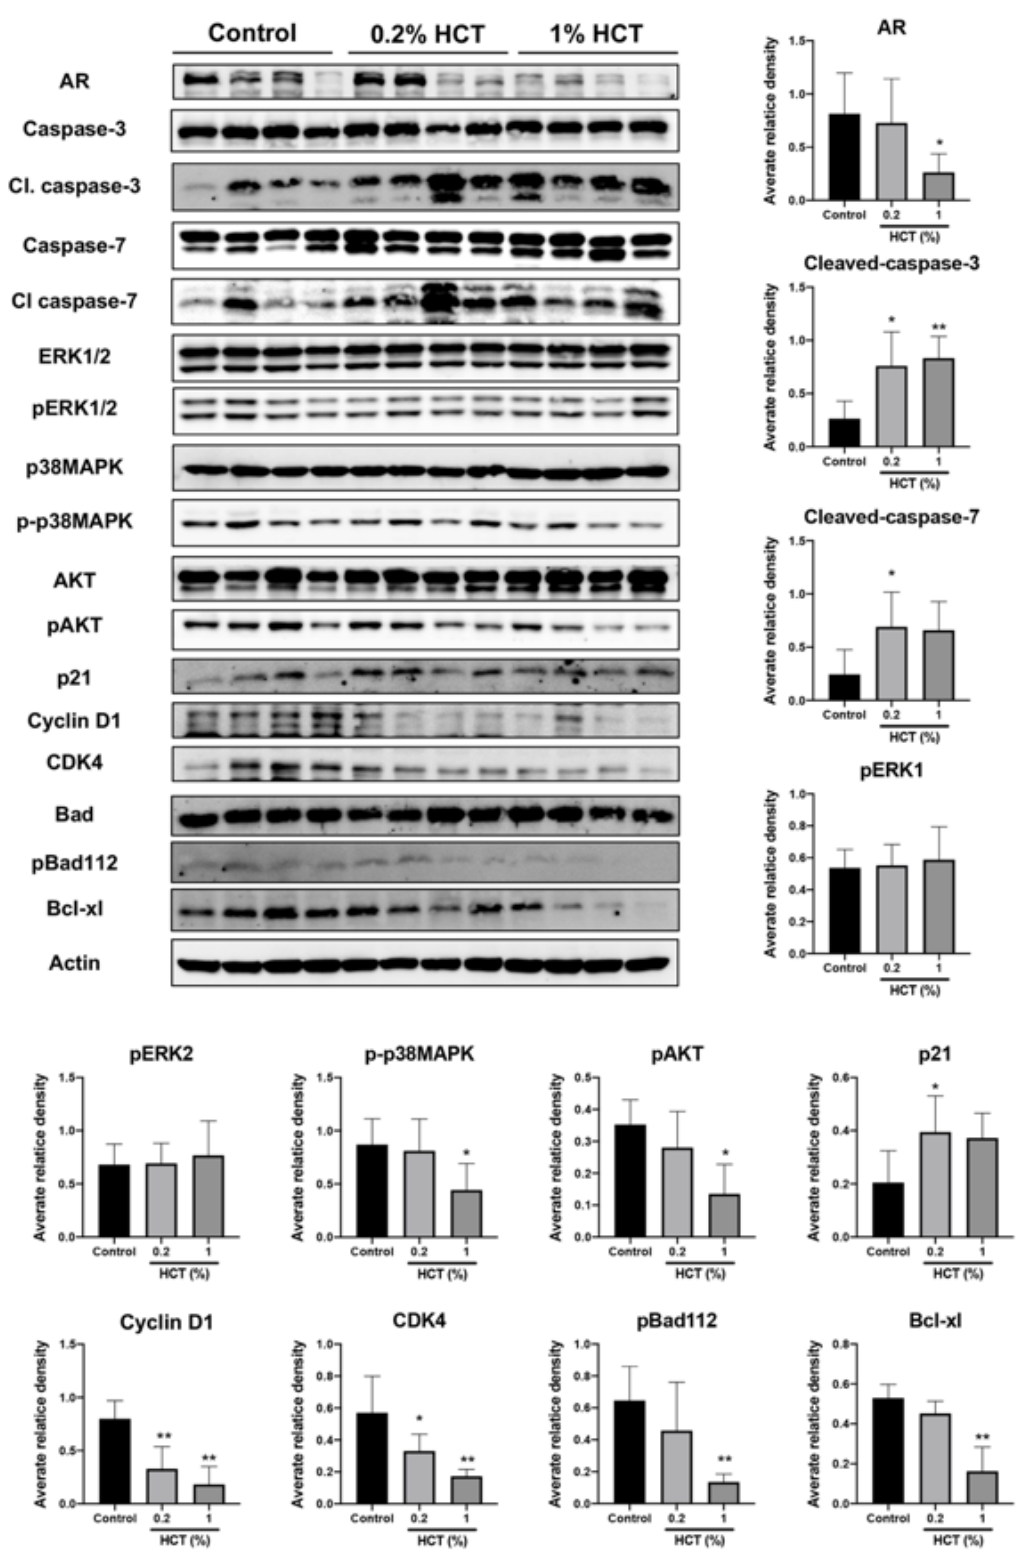
Figure 8. Effect of HCT on protein expression in the TRAP model. Immunoblotting and average relative band density for cell proliferation and apoptosis-related proteins in prostate lateral lobe. Whole un-cropped images see Figure S7. Bar graphs represent the mean ± SD. * p < 0.05 and ** p < 0.01 vs. control. HCT, Houttuynia cordata Thunb.; TRAP, Transgenic Rat for Adenocarcinoma of